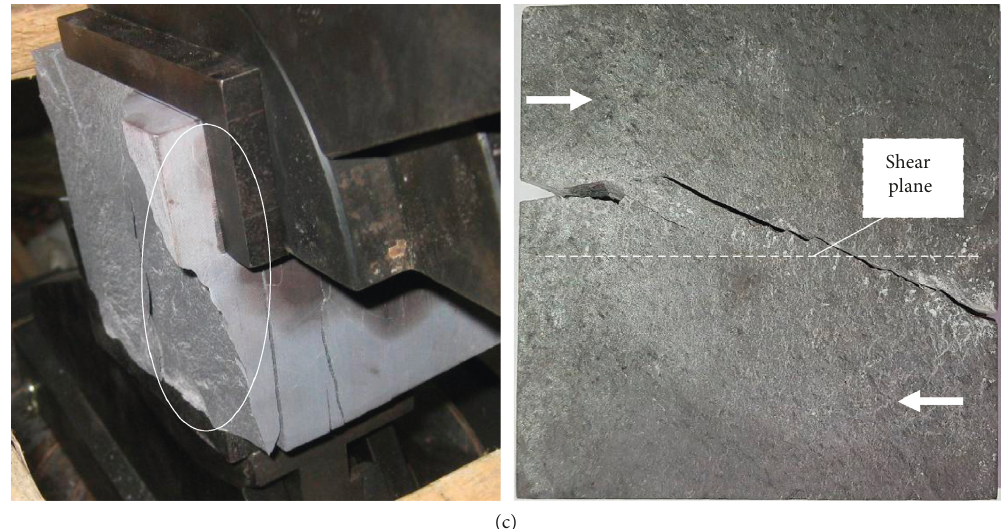
Figure 7: Failure patterns of slate with different loading modes in shear